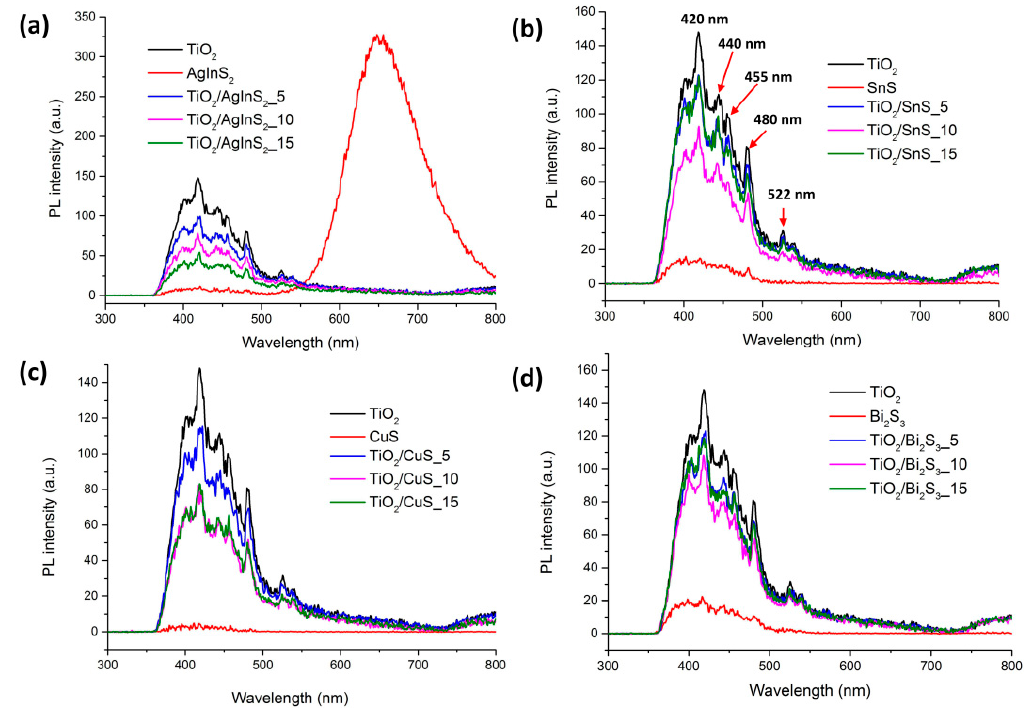
Figure 4. PL spectra of ( a ) TiO 2 , AgInS 2 and TiO 2 modified with AgInS 2 (5, 10, 15 wt%), ( b ) TiO 2 , SnS and TiO 2 modified with SnS (5, 10, 15 wt%), ( c ) TiO 2 , CuS 2 and TiO 2 modified with CuS (5, 10, 15 wt%), ( d ) TiO 2 , Bi 2 S 3 and TiO 2 modified with Bi 2 S 3 (5, 10, 15 wt%).